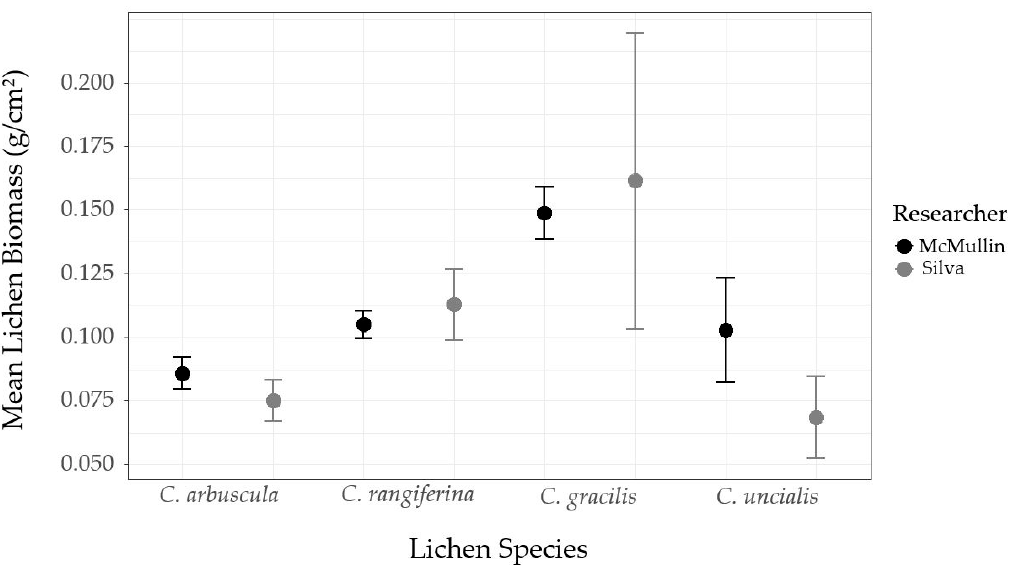
Figure A1. Mean biomass (g / cm 2 ) recorded for each Cladonia spp. ground lichen destructively sampled by McMullin [33] and Silva (this study). Error bars represent ± 1 SE.